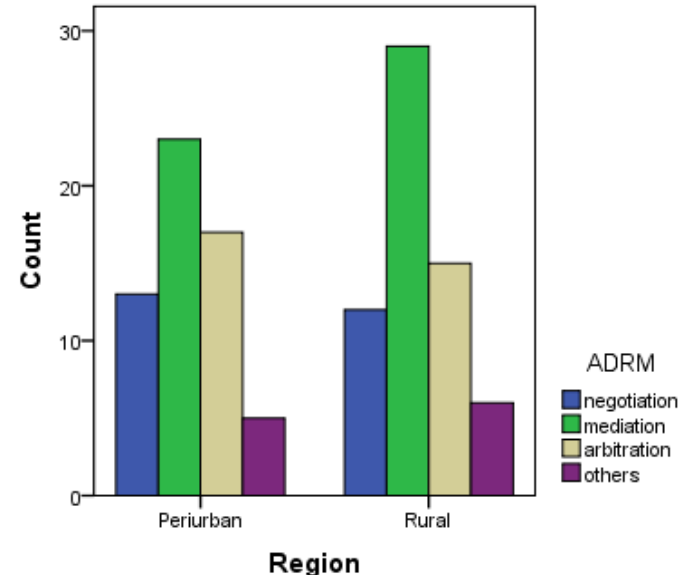
Figure 2. Employed ADR